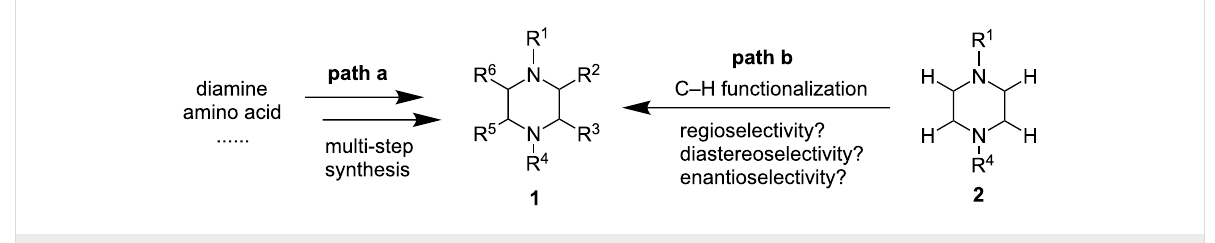
Figure 2: Strategies for the synthesis of carbon-substituted piperazines.